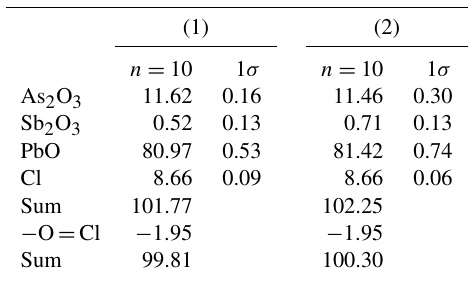
Table 1. EPMA chemical data (wt%) for heliophyllite from holo- type specimen NRM18880482 (1). F, P, Ca, V, Mn and Fe were below their respective detection limits in all spot analyses. Chem- ical data for ecdemite (2) in Perchiazzi et al. (2019) are given for